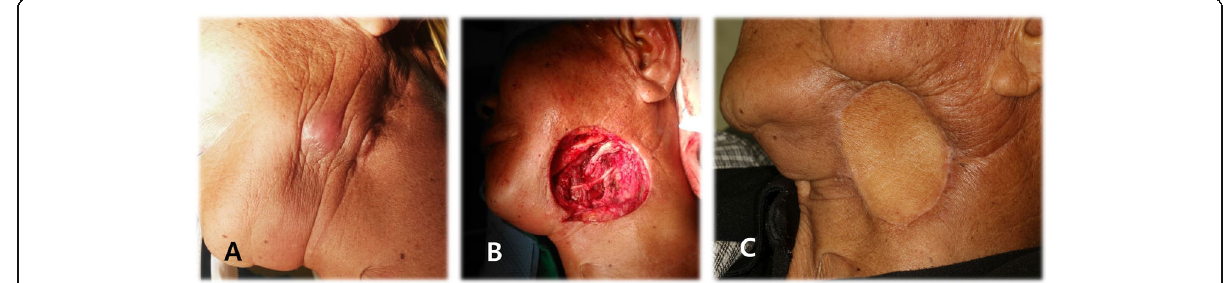
Fig. 3 Reconstruction of skin defect on mandible with the supraclavicular artery island flap in patient 3 (left side). a Skin lesion of 10 × 9 mm. b Skin defect of 20 × 20 mm. c Complete healing of recipient site at 4 months after